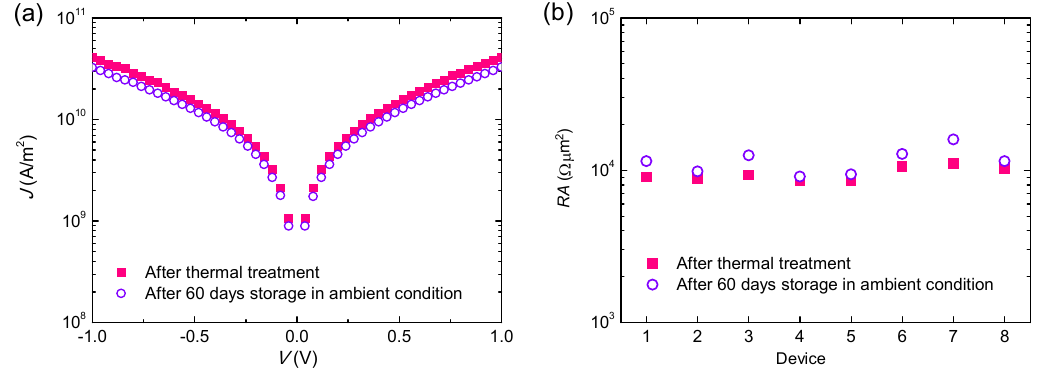
Figure 6. ( a ) The J ( V ) characteristics of OPD-2 junctions measured after being annealed at 400 K and 60 days of storage in ambient conditions. ( b ) RA values for 8 OPD-2 junctions measured after being annealed at 400 K and 60 days of storage in ambient conditions.